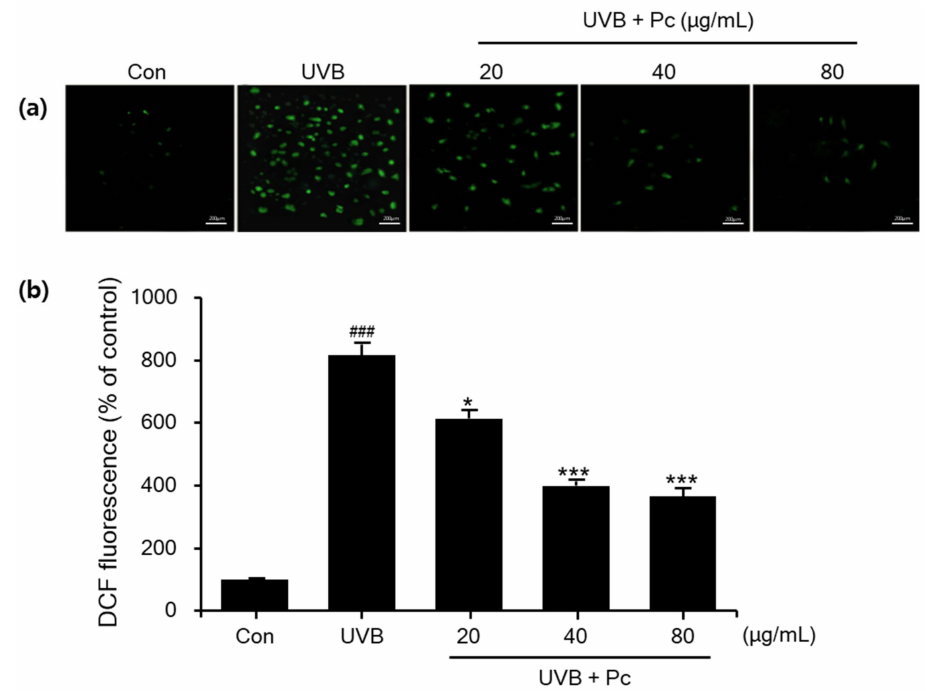
Figure 5. Effects of C-phycocyanin (C-PC) on ultraviolet B (UVB)-induced intracellular reactive oxygen species (ROS) levels. ( a ) HaCaT cells were seeded in 96-well plates and incubated with 2 (cid:48) ,7 (cid:48) - dichlorofluorescin diacetate (DCFDA) dye prior to UVB exposure. ( b ) ROS levels were measured at 6 h post-UVB radiation along with treatment with the indicated concentrations of C-PC. Scale bars, 200 µ m. Data are presented as the mean ± SD of three independent experiments. ### p < 0.001 vs. control group. * p < 0.01 and *** p < 0.001 vs. UVB/vehicle